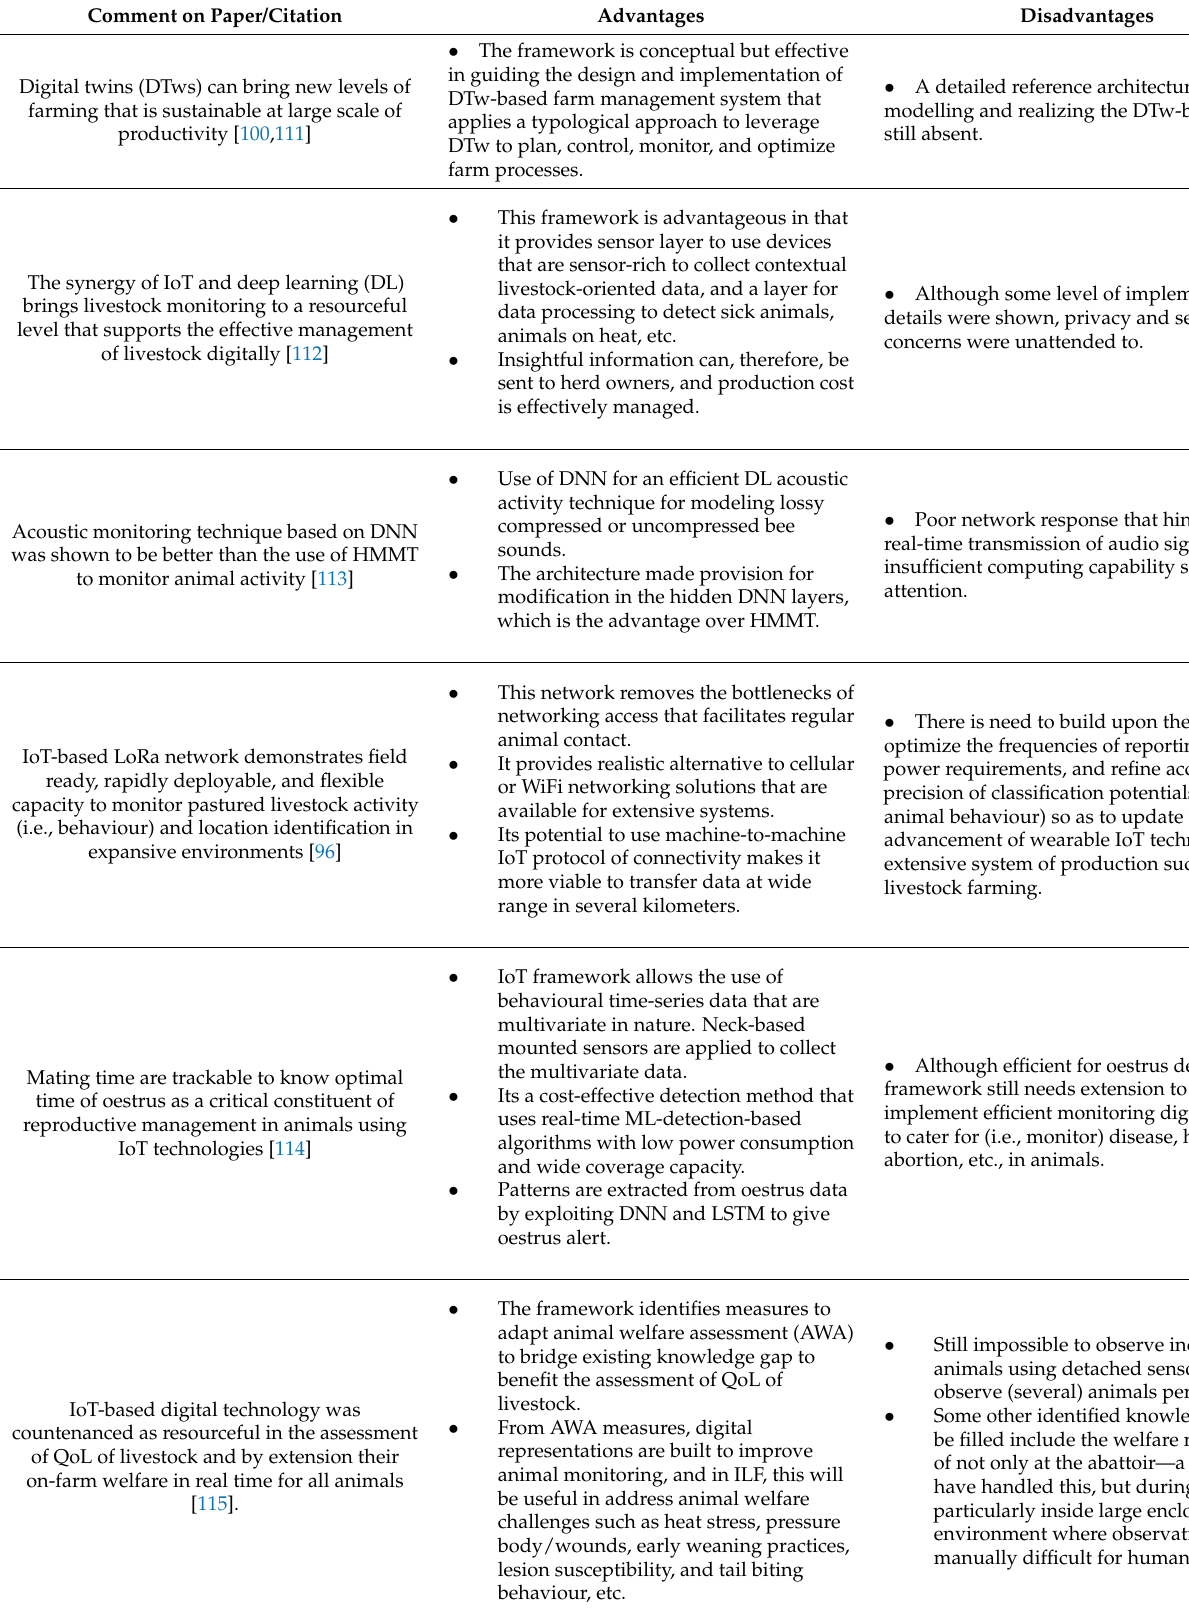
Table 7. IoT application in livestock